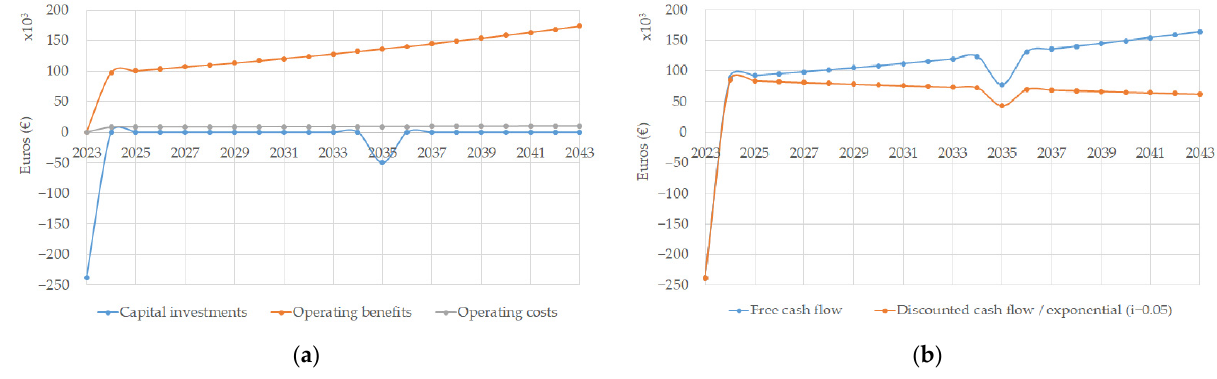
Figure 18. Monetary flows for the project (differential approach); ( a ) benefits, costs, and investment; ( b ) free cash flow and discounted cash flow (traditional exponential discounting with i E = 0.05).